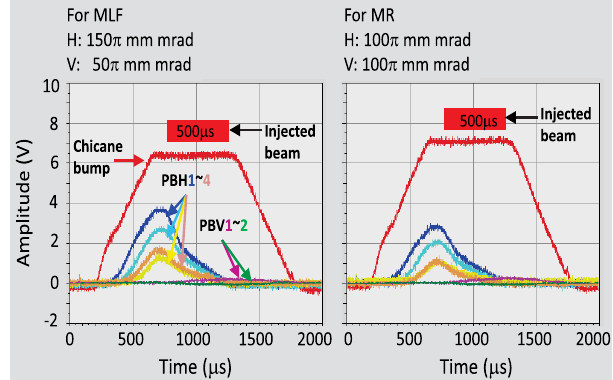
FIG. 10. Waveforms of painting and chicane bump magnets for the MLF (left) and MR (right) painting. The painting areas for the MLF was 150 and 50 (cid:1) mm mrads for the horizontal and vertical direction, respectively, where it was 100 (cid:1) mm mrad for both directions for the MR.